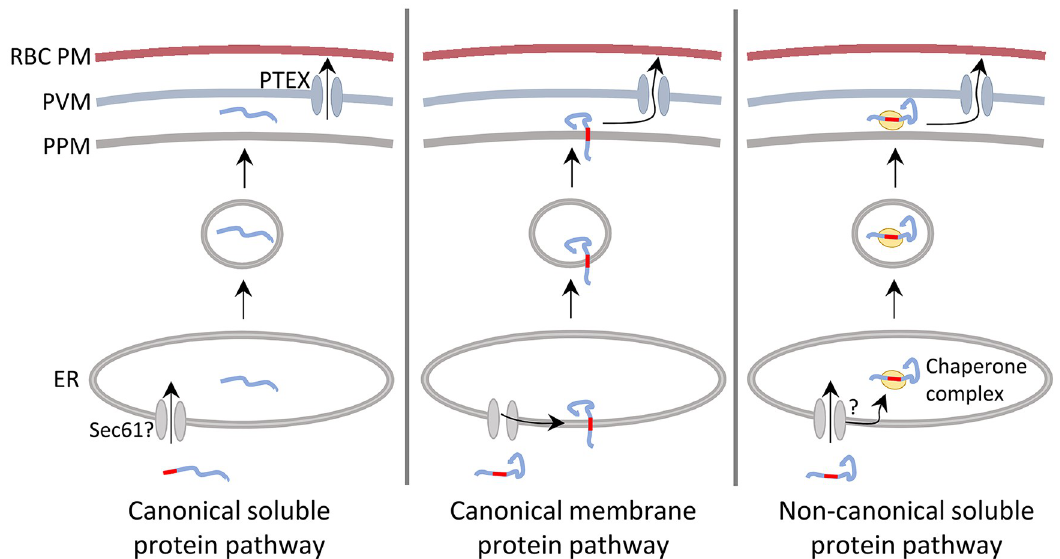
Fig 7. A model of the ways by which exported proteins can traverse the parasite secretory pathway. RBC PM, red blood cell plasma membrane; PVM, parasitophorous vacuole membrane; PPM, parasite plasma membrane; ER, endoplasmic reticulum. Hydrophobic targeting sequences (signal sequences or transmembrane segments) are shown in